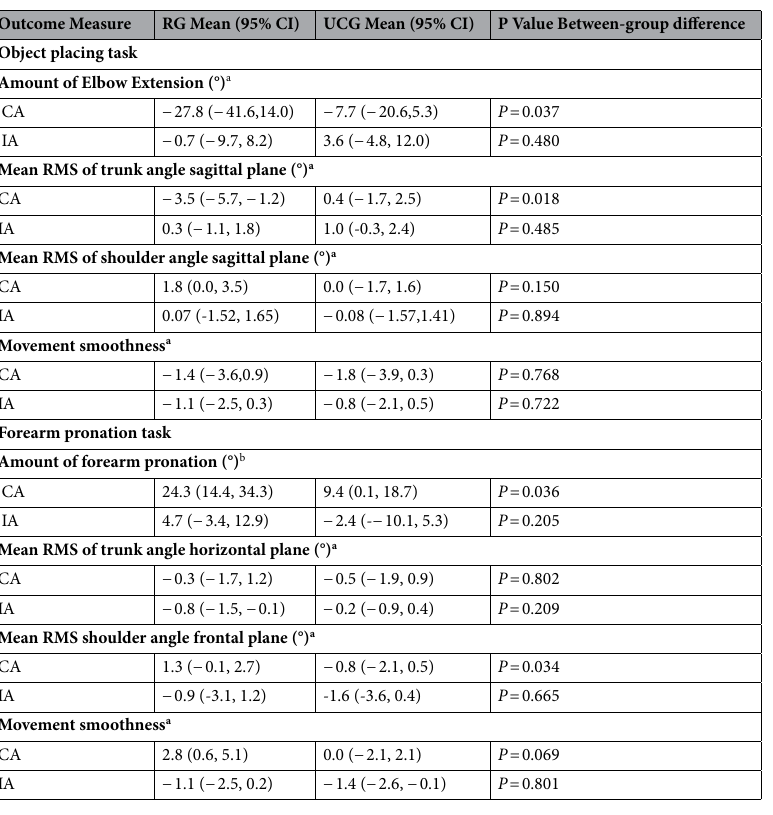
Table 3. Mean and 95% confidence interval (CI) of change scores (post-baseline values) of kinematic parameters for Robot group (RG) and Usual care group (UCG). RMS, root mean square; CA, Contralesional arm; IA, Ipsilesional arm. P -values indicate the results of the comparison between RG and UCG according to the analysis of covariance (ANCOVA), adjusted for baseline score. a Lower scores indicate better performance. b Higher scores indicate better